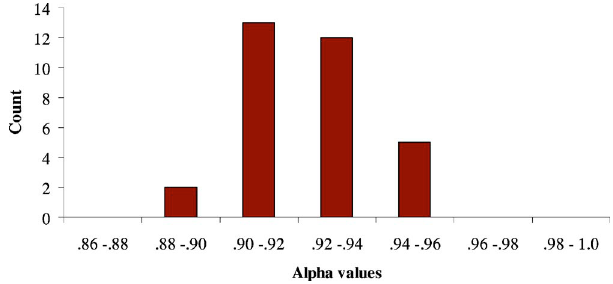
FIG. 3. (cid:1) Color (cid:2) A histogram of alpha coefficients for the semes- ter set of exams for each of the 32 courses for all students (cid:1) A–F (cid:2)